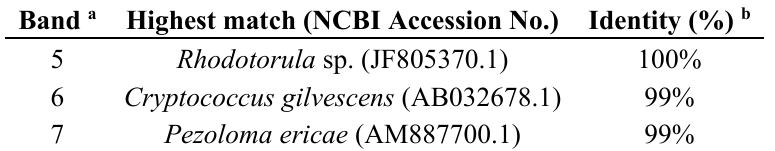
Figure 4. DGGE profiles of the fungal communities showing the comparison of the fungal soil communities in 13 different crust samples (C01–C13). L1: markers 1–7 correspond to bands present in different samples. White arrows: bands excised, re-amplified and sequenced. Table 4. Highest identities found for bands from the DGGE